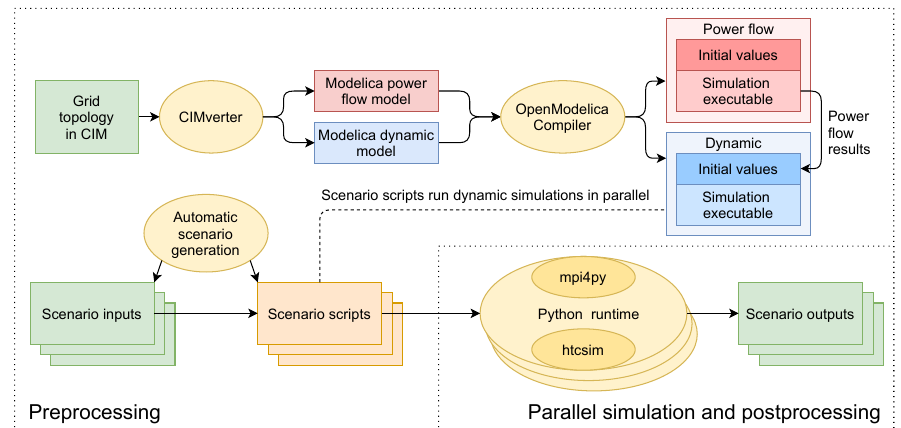
Figure 2. Overall concept of the htcsim-based environment for parallel scenario